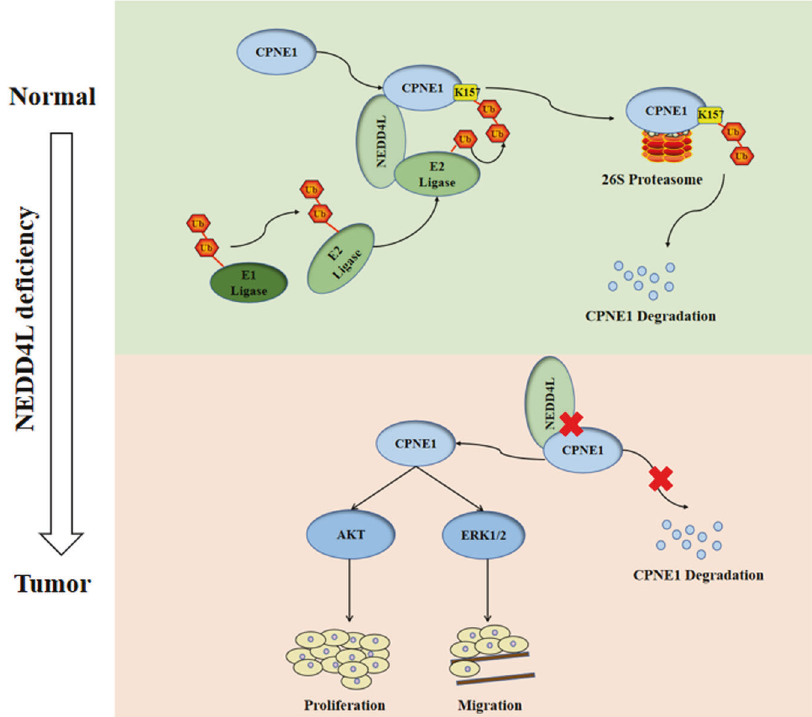
Fig. 8 The hypothetical model for the functional interplay of CPNE1 with NEDD4L in non-small-cell lung cancer cells. A merchanism working model of NEDD4L regulates the CPNE1. removed after 24 h in both the migration and invasion assays. Images were acquired using a microscope (CKX41, Olympus). Xenografts BALB/c athymic nude mice (female, 4 – 6 weeks old, weighing 16 – 20 g) were purchased from the Experimental Animal Center of Soochow